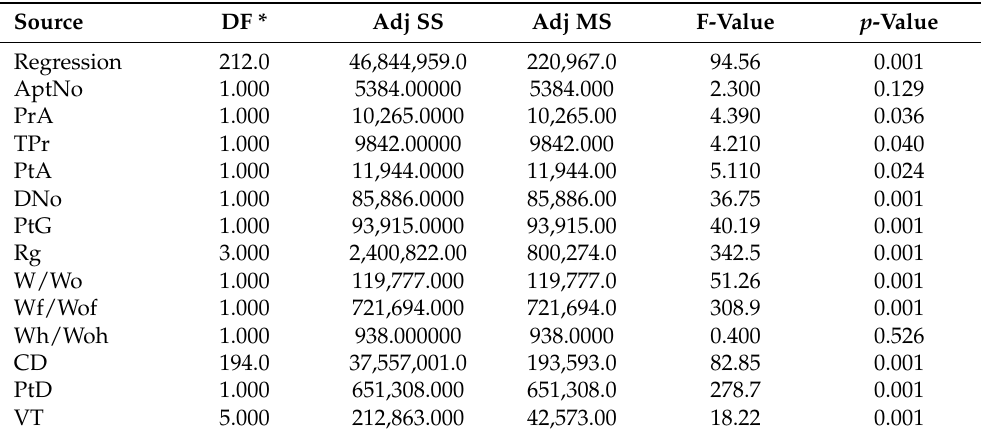
Table 3. Statistical values of the effects of independent variables on the duration of the home health